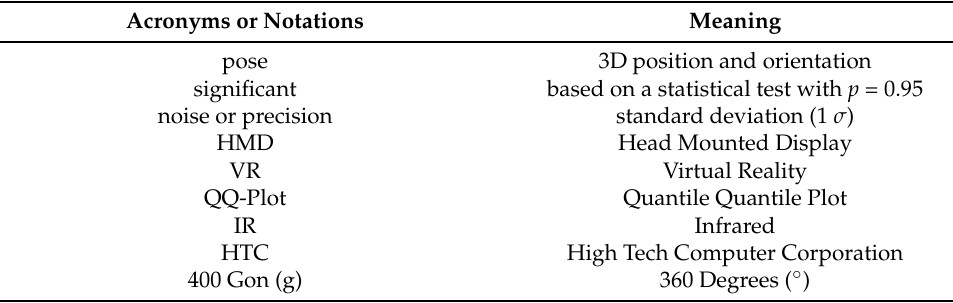
Table 1. List with acronyms and